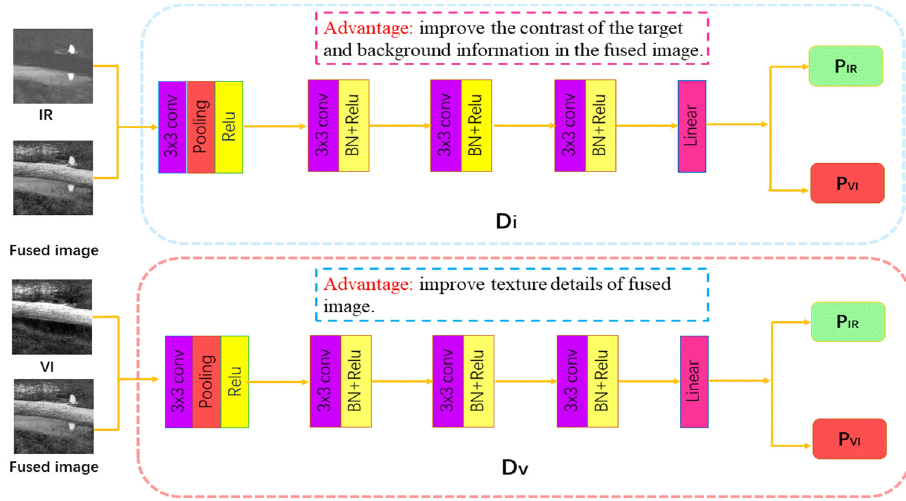
Figure 4. Network architecture of discriminators.